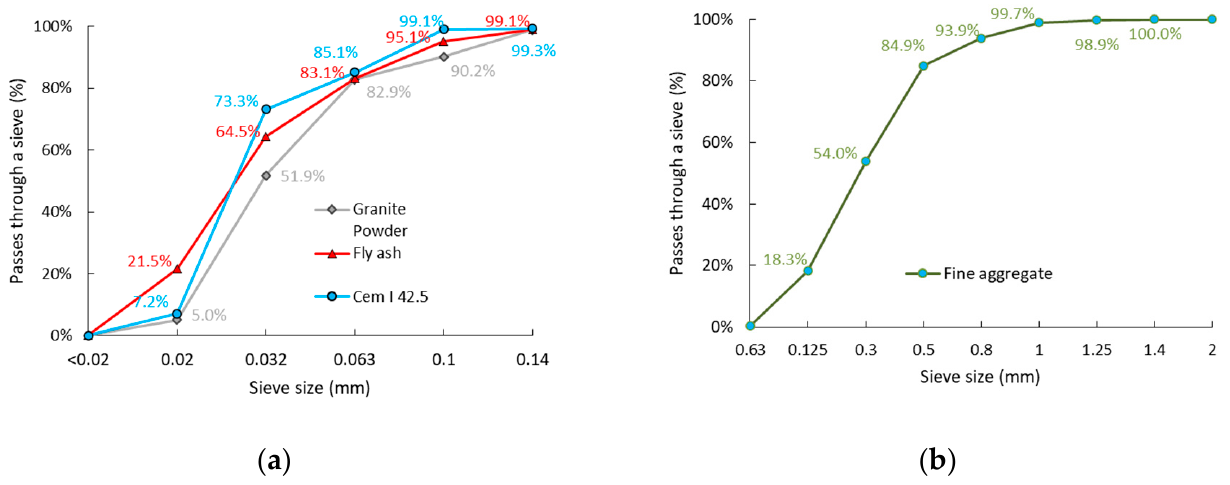
Figure 7. Sieve size development for the ( a ) binders and ( b ) fine aggregate that were used in the research.